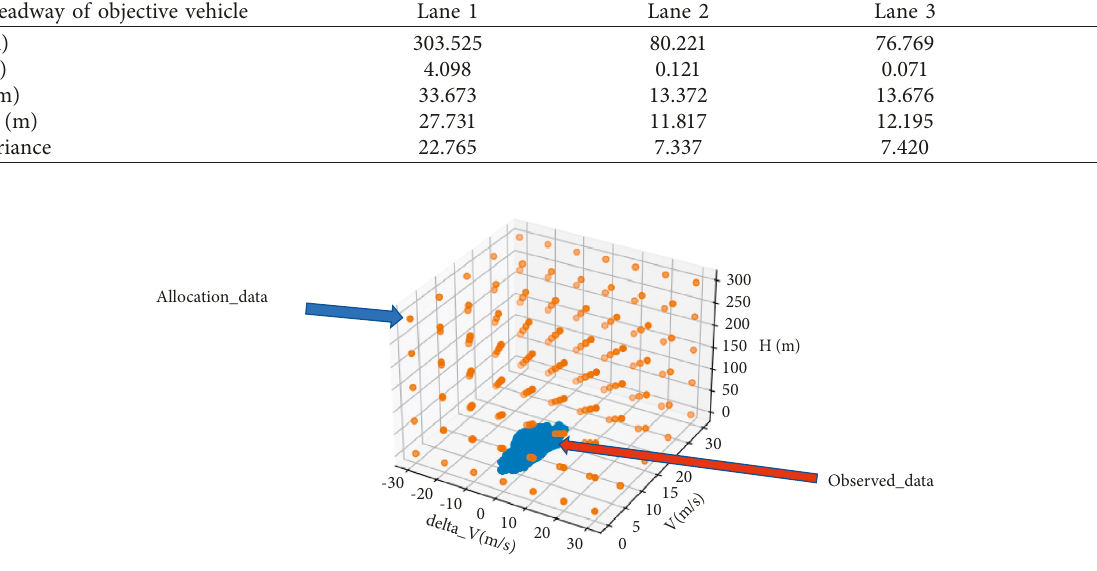
Figure 5: The descriptions of the allocation data and the observed